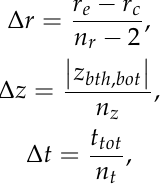
where 𝑛 𝑡 is the total number of time steps, 𝑛 𝑟 and 𝑛 𝑧 are the total number of grid cells